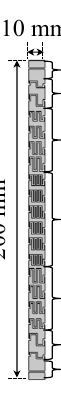
Figure 6. Calculated results of the waveguide length for the acoustic flat lens. The solid line is the theoretical value, and the dots are the optimized values. The horizontal axis corresponds to the y coordinate in Figure 5. The focal length and the aperture size are chosen as f = 10.5 ∆ d = 105 mm and a = 200 mm, respectively. The values of #1–#3 are used for the structures of #1–#3 in Figure 2. A 1D straight acoustic waveguide structure ( w = 0.8 mm and l = ∆ d = 10 mm) is used for the position at y = 95 mm, as in the case of Figure 3.